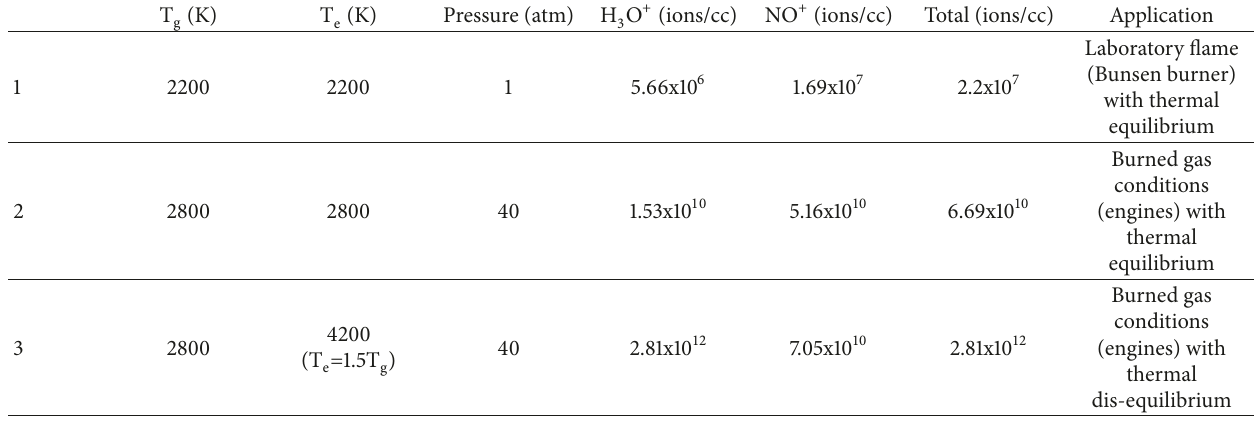
Table 5: Effect of T , T and pressure on equilibrium concentration of ions (mixture II) in a stoichiometric propane-air mixture. e g